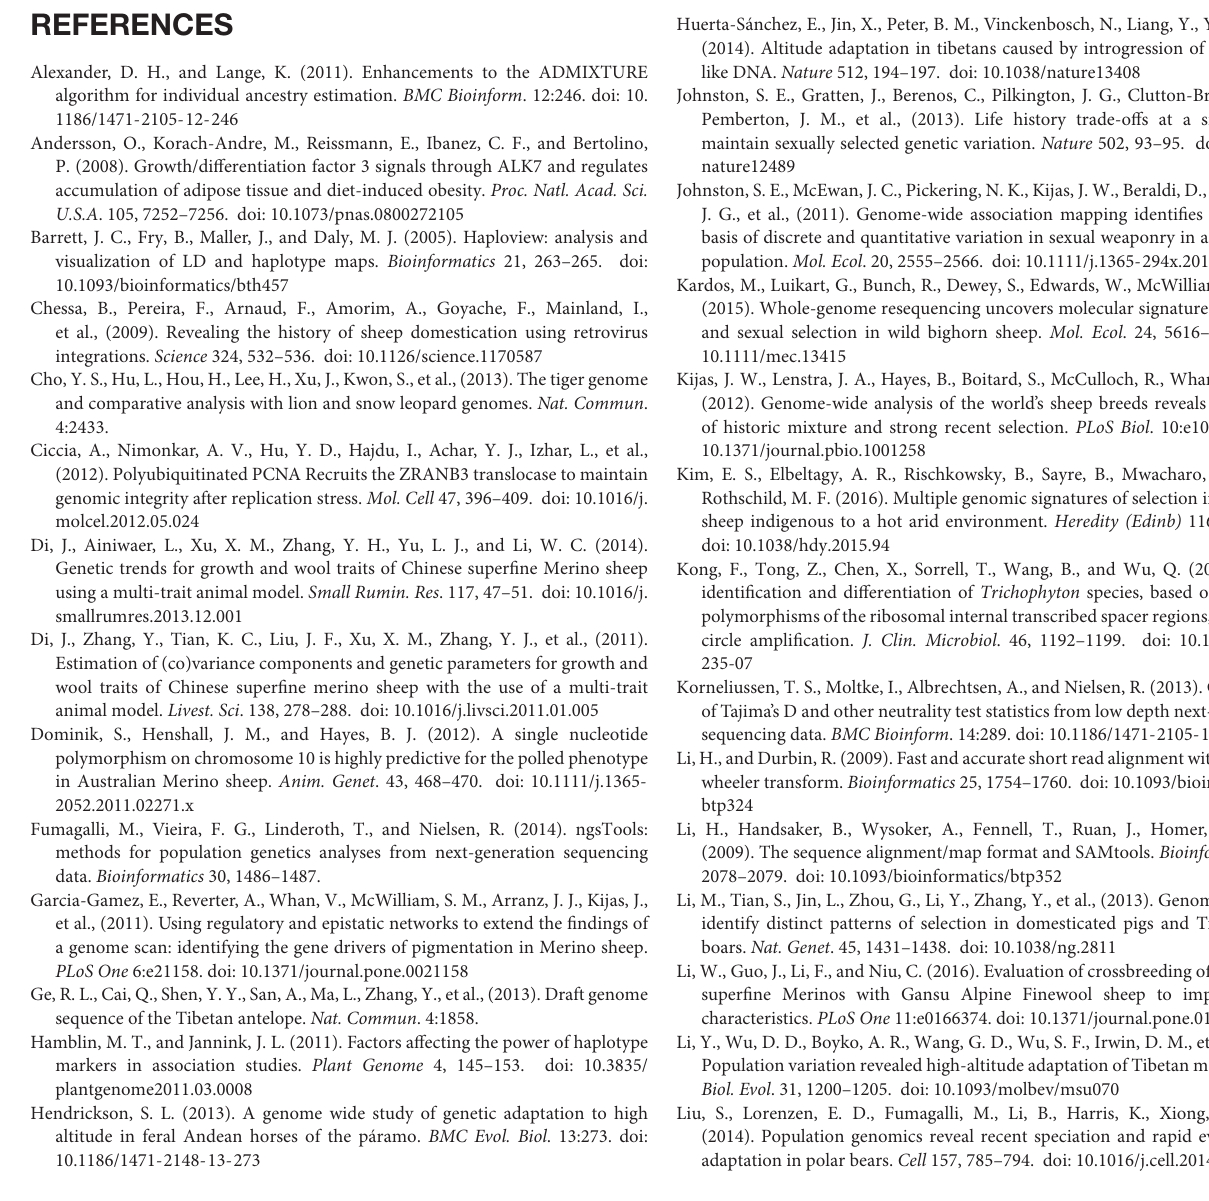
Supplementary Figure 7 | Inter-species comparison of Chinese merino sheep (horn) and Aohan fine-wool sheep (polled). Supplementary Table 1 | Introduction of the four sheep breeds examined in the present study. Supplementary Table 2 | Number of reads and bases in quality control. Supplementary Table 3 | Read mapping statistics and coverage of depth. Supplementary Table 4 | Candidate genes list. Supplementary Table 5 | Genotypic and allelic frequencies, expected heterozygosity ( He ), effective allele number ( Ne ), polymorphism information content ( PIC ), and Hardy–Weinberg equilibrium ( HWE ) testing p- value of single-nucleotide polymorphisms (SNPs) identified in MSH6, PIGO, PIGM,